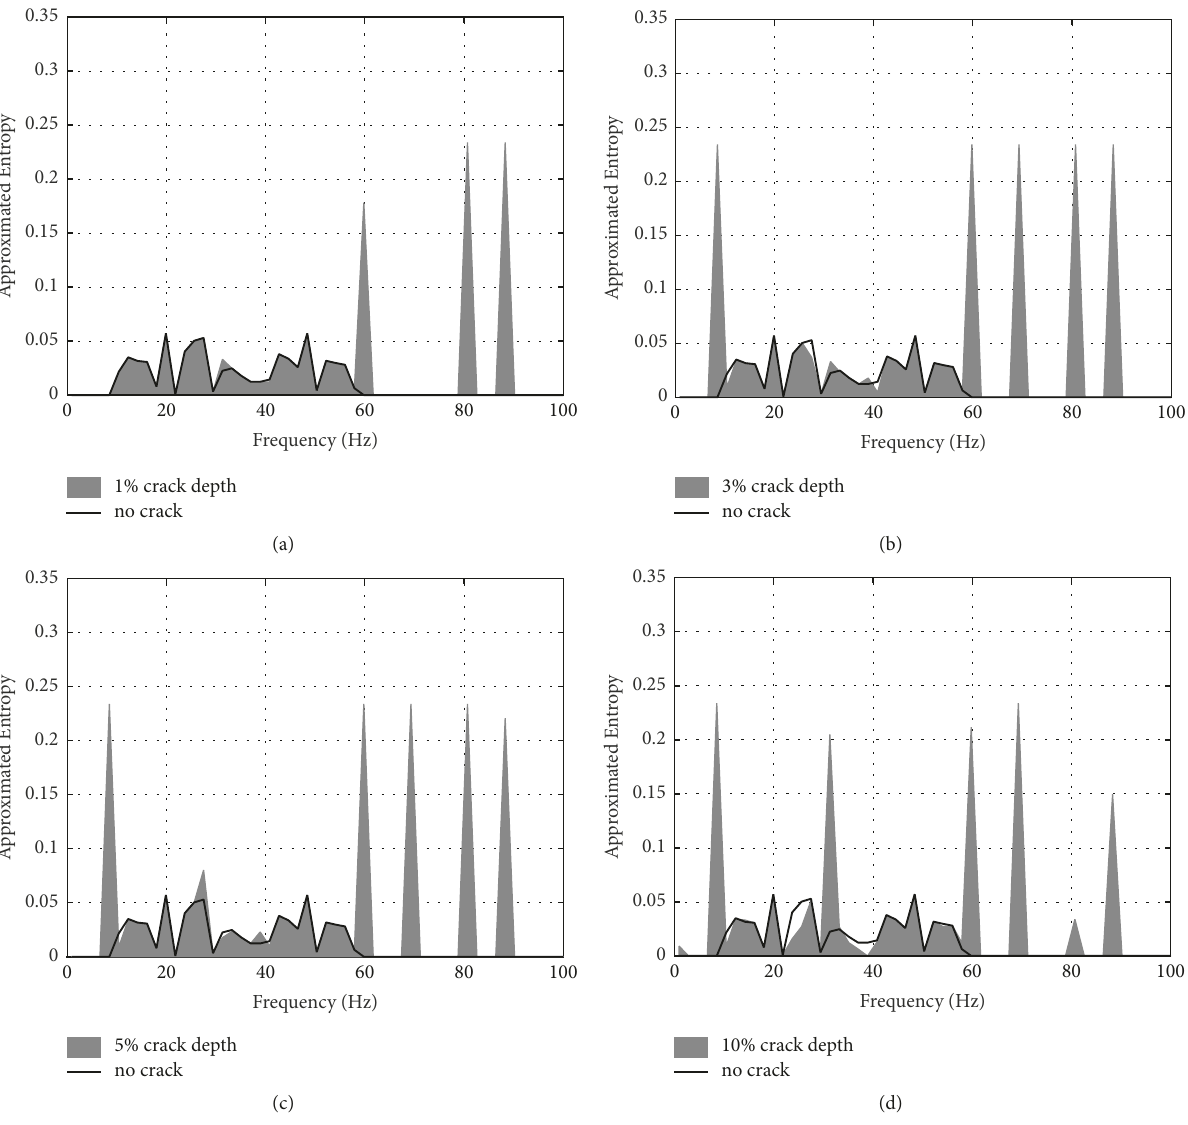
Figure 8: Approximated Entropy of the FFTs with no noise. Comparison between the cases of healthy and cracked shaft: (a) 1% crack depth; (b) 3% crack depth; (c) 5% crack depth; (d) 10% crack